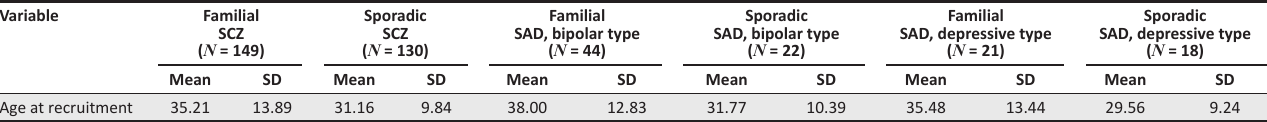
Age at recruitment